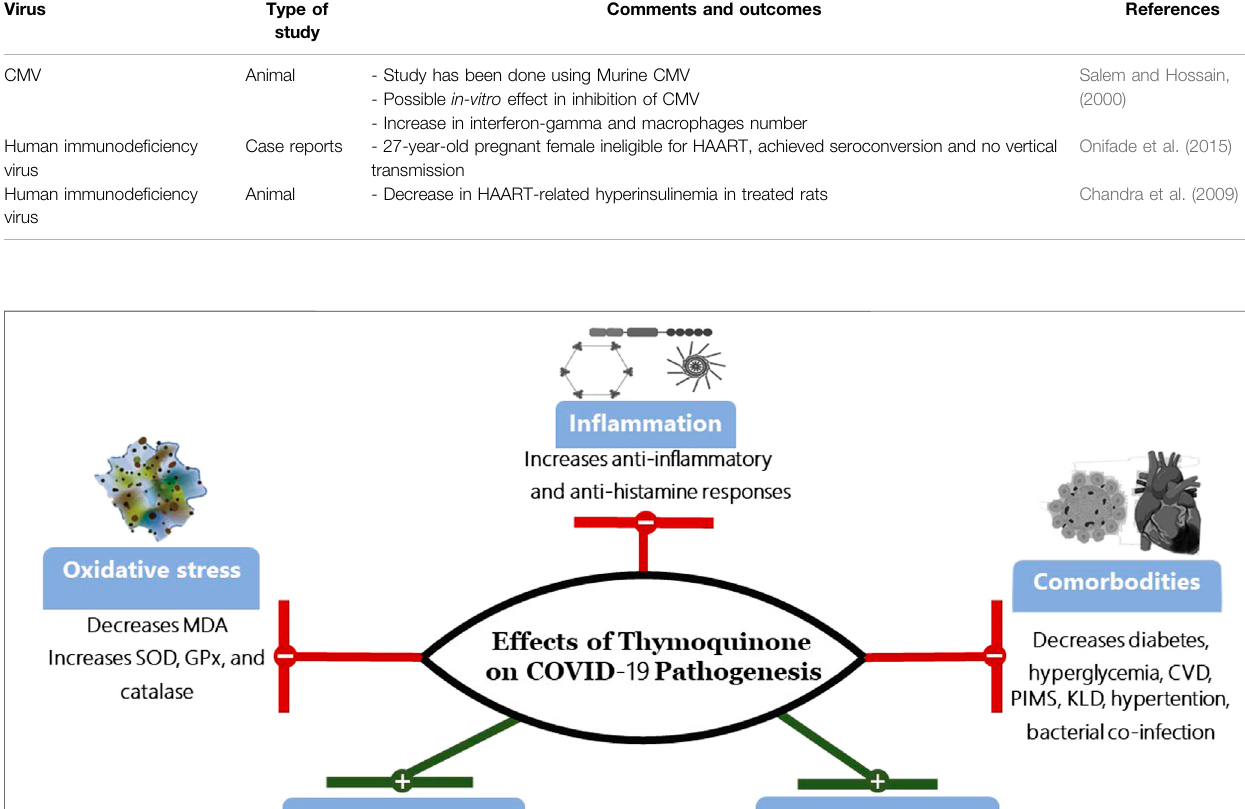
Frontiers in Pharmacology |